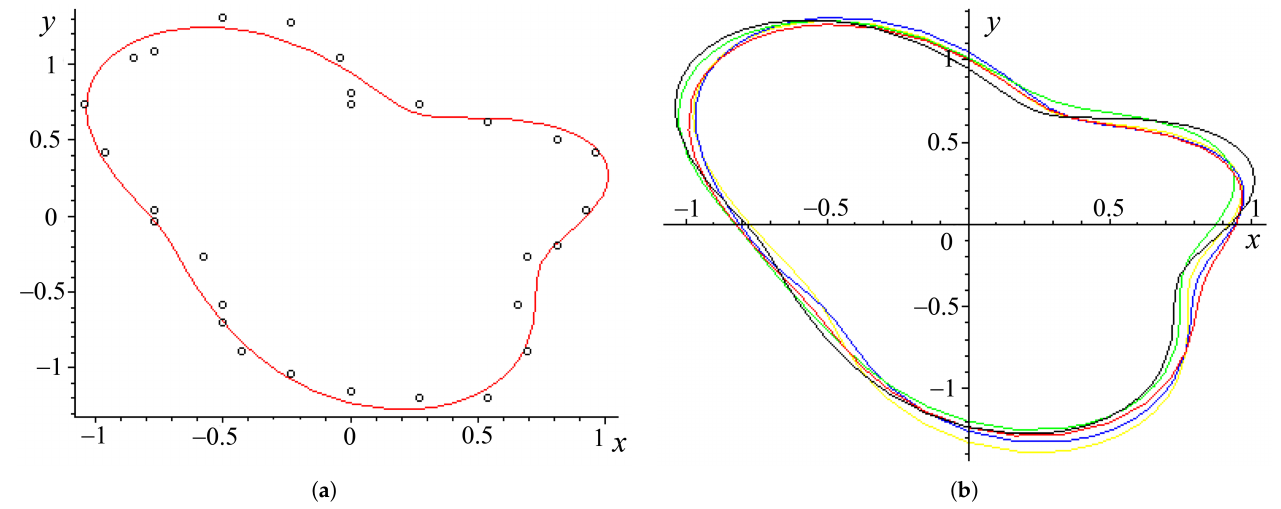
Figure 7. ( a ) The shape function fitting curve of grain; ( b ) the function fitting curve of grain 1 under different loading steps.